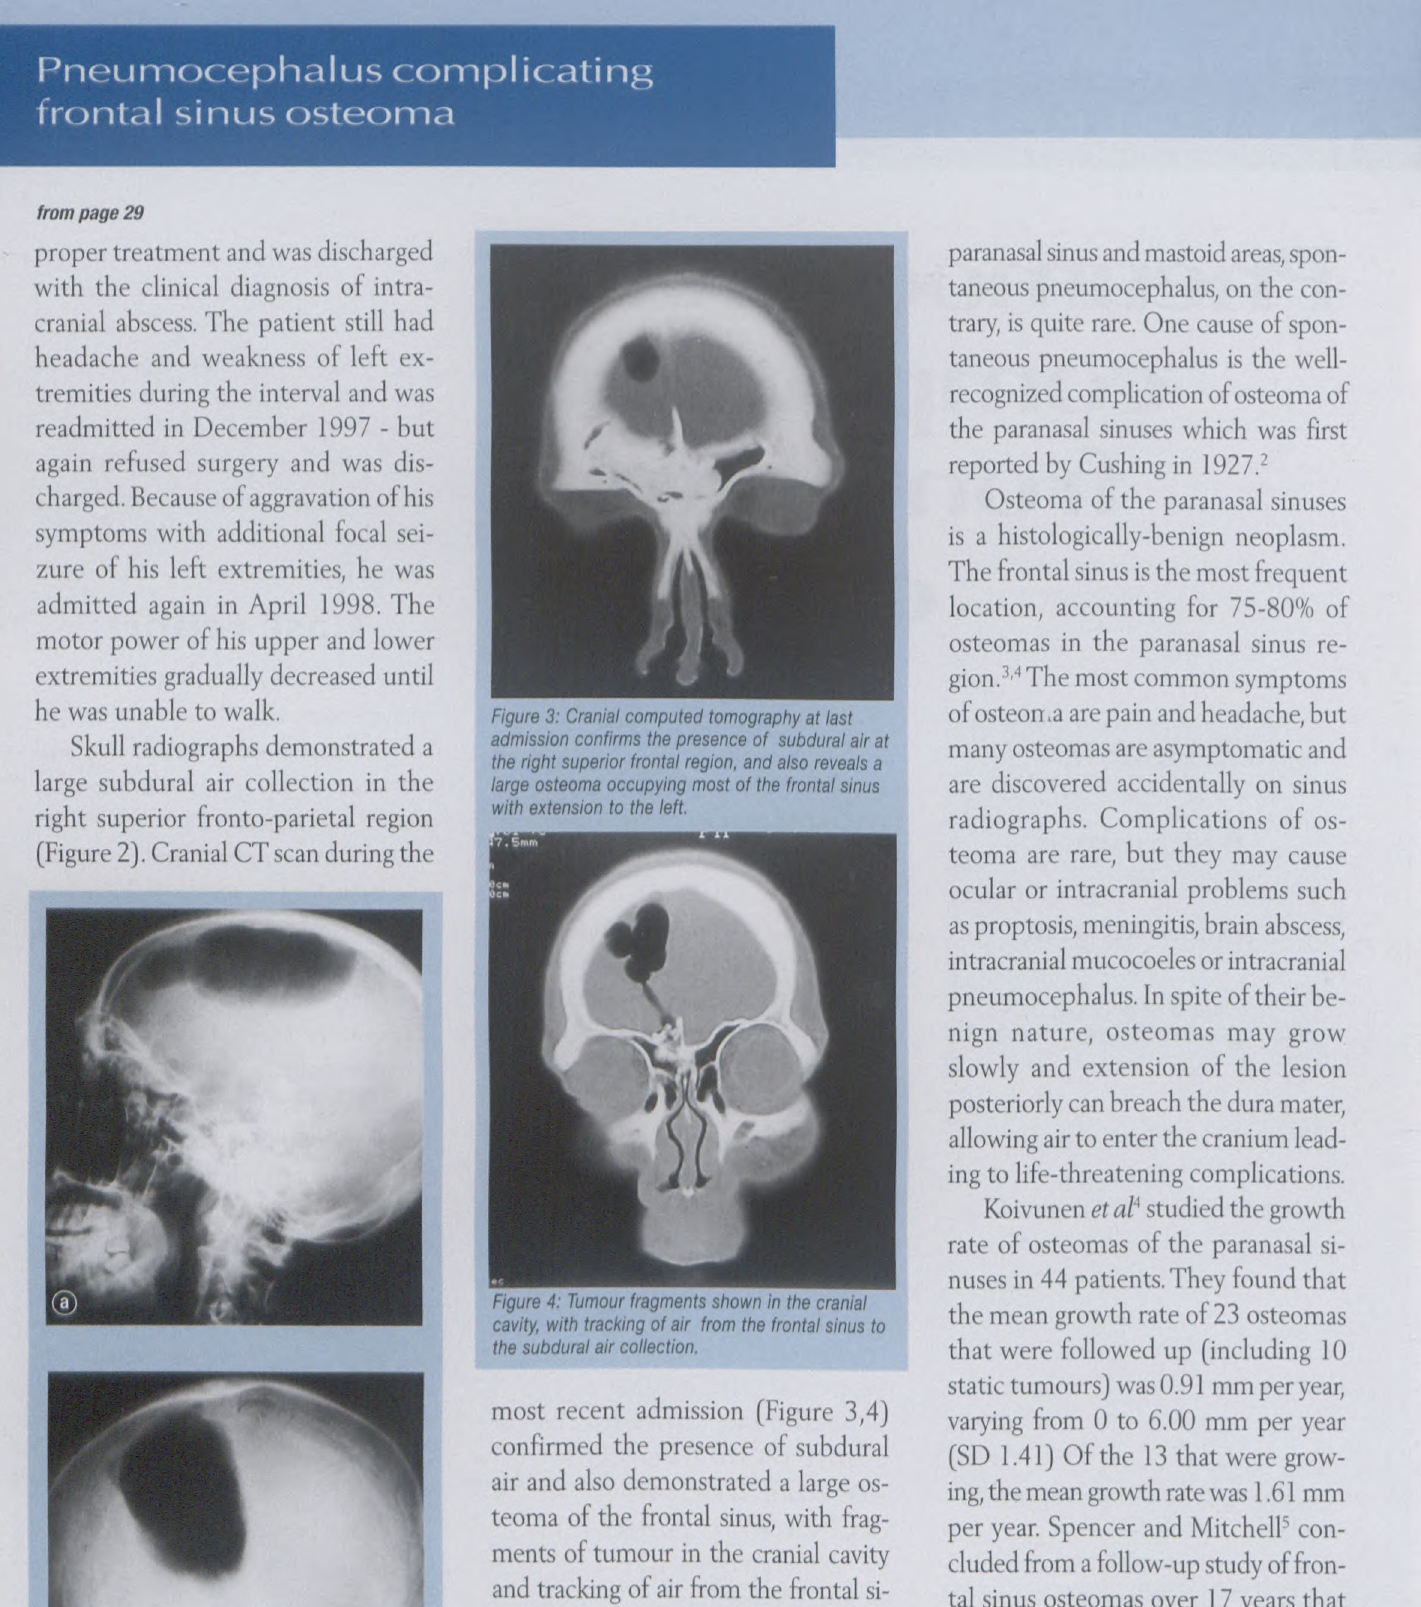
Figure 4: Tumour fragments shown in the cranial cavity, with tracking of air from the frontal sinus to the subdural air